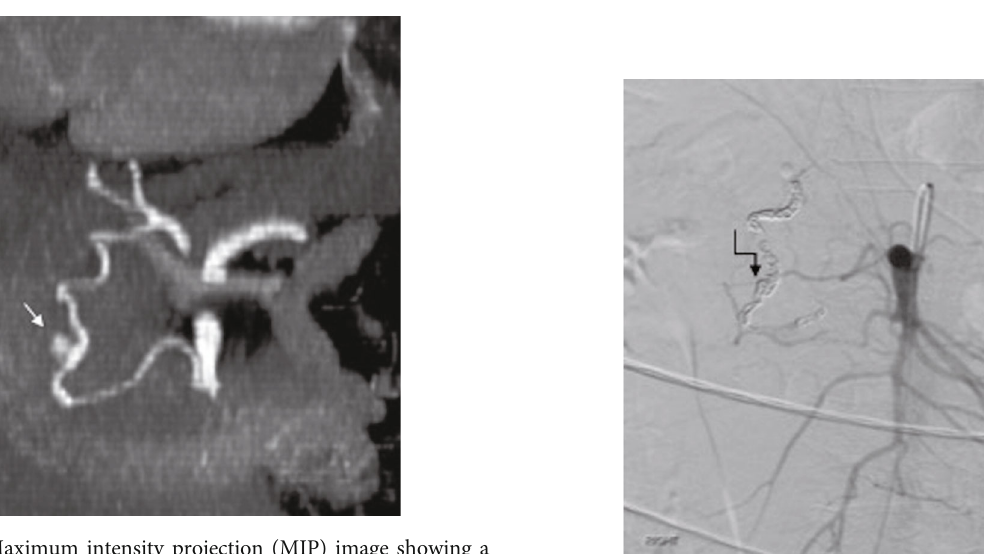
Figure 3: Superior mesenteric arteriography showing the arc of Buhler with a short segment of fusiform dilatation and active extravasation (arrowhead). Hepatofugal fl ow was seen with brisk opaci fi cation of the proper hepatic artery. The cause of which was unknown.